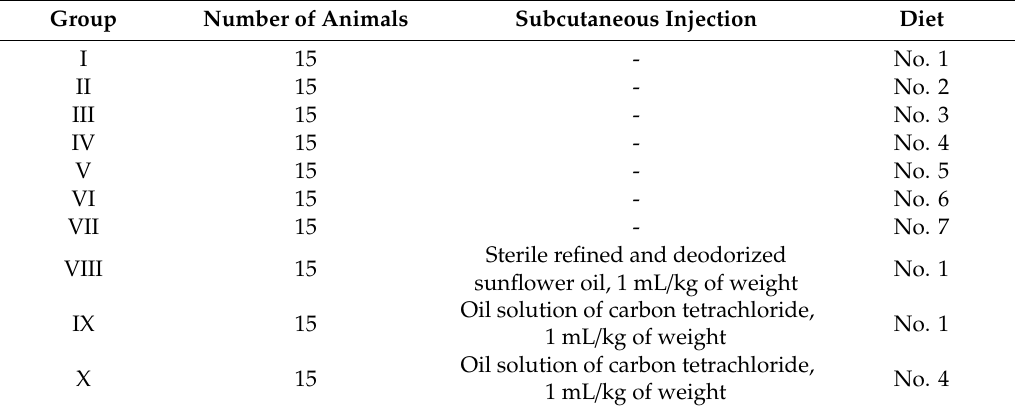
Table 3. Experimental